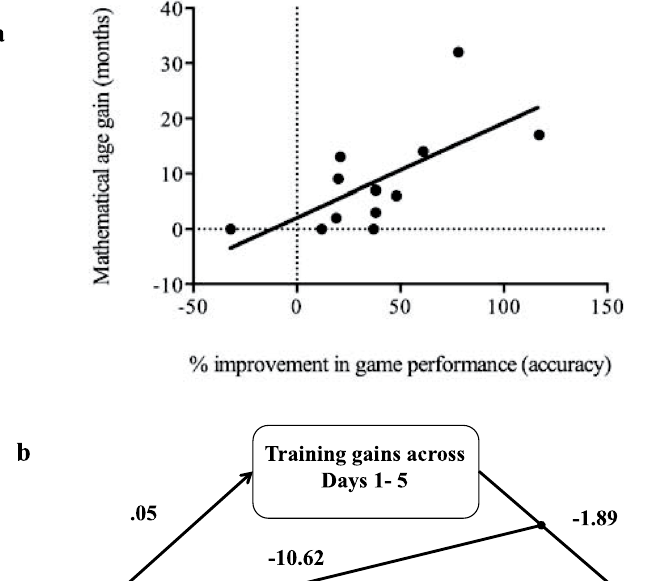
Overall, the current study contributes insights into the novel concept of combining tRNS and cognitive train- ing for mitigating developmental disorders. This approach addresses the ethical dilemma of depriving a consid- erable population of children of potentially improved cognitive abilities, which could have important individual and socioeconomic implications 5 . These experimental data is a first step towards addressing current debates that lacked empirical evidence, while raising open questions that are fundamental to understanding the workings and potential of brain stimulation use on children 11, 48 . Addressing these questions would require systematic replications involving randomised double-blinded controlled studies on larger samples, different educational/ cultural systems, physiological data on the underlying neural and cognitive mechanisms 49 , and children with other atypical developmental conditions 5, 50 . Cognisant of the growth in public interest and do-it-yourself (DIY) application of brain stimulation for cognitive enhancement 51 , we emphasize that the current early-stage find- ings serve as impetus for further scientific investigations, but not support or justification for tRNS application outside the experimental context. While we did not find any evidence that would raise safety concerns, chil- dren in our sample were carefully selected and strictly assessed for their eligibility to receive brain stimula- tion. Randomised-controlled studies with larger sample sizes that are more likely to be achieved by multi-site